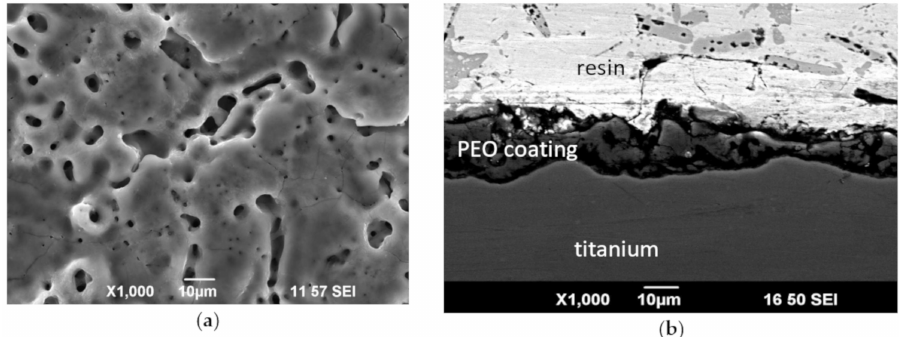
Figure 1. SEM images of the PEO coating: ( a ) Top view; ( b ) Cross-section.